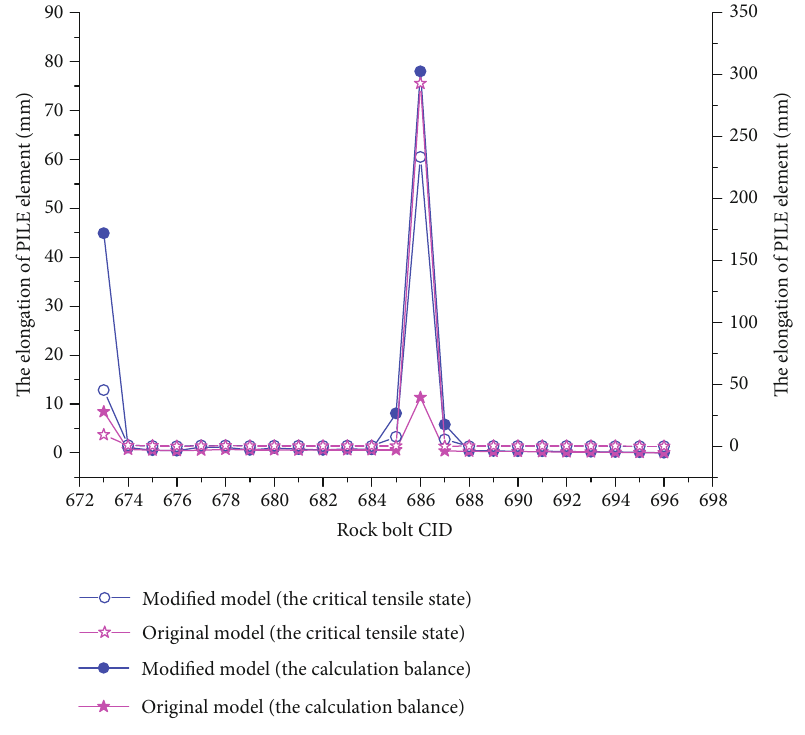
Figure 20: The elongation distribution of rock bolt No. 14 under di ff erent states.